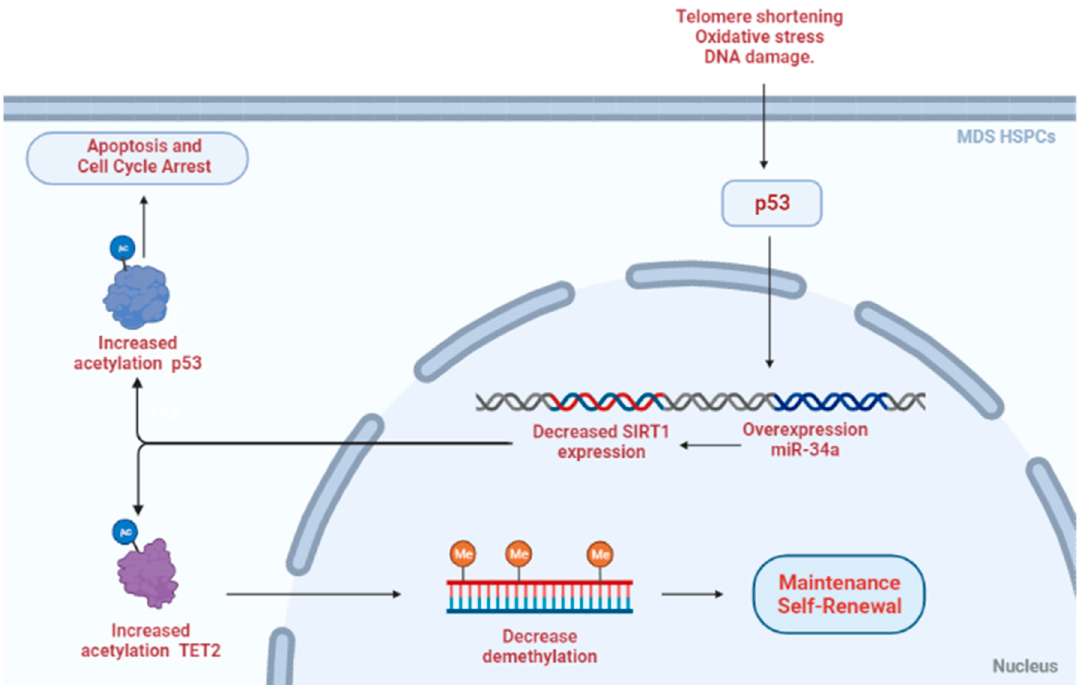
Figure 4. NAD+ synthesis and protein deacetylase activity by sirtuins in MDS.